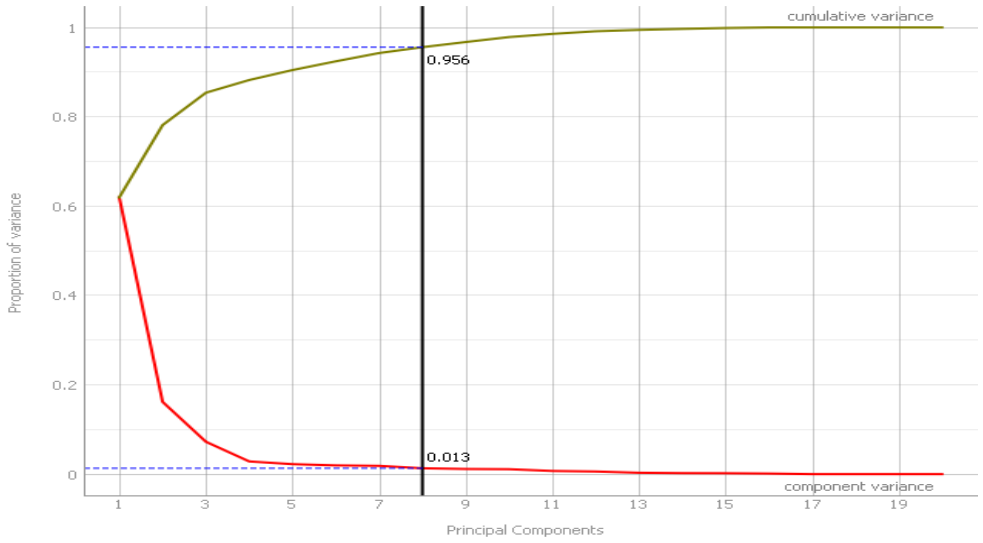
Figure 5. Principal component analysis (PCA) selection. Table 10. PCA